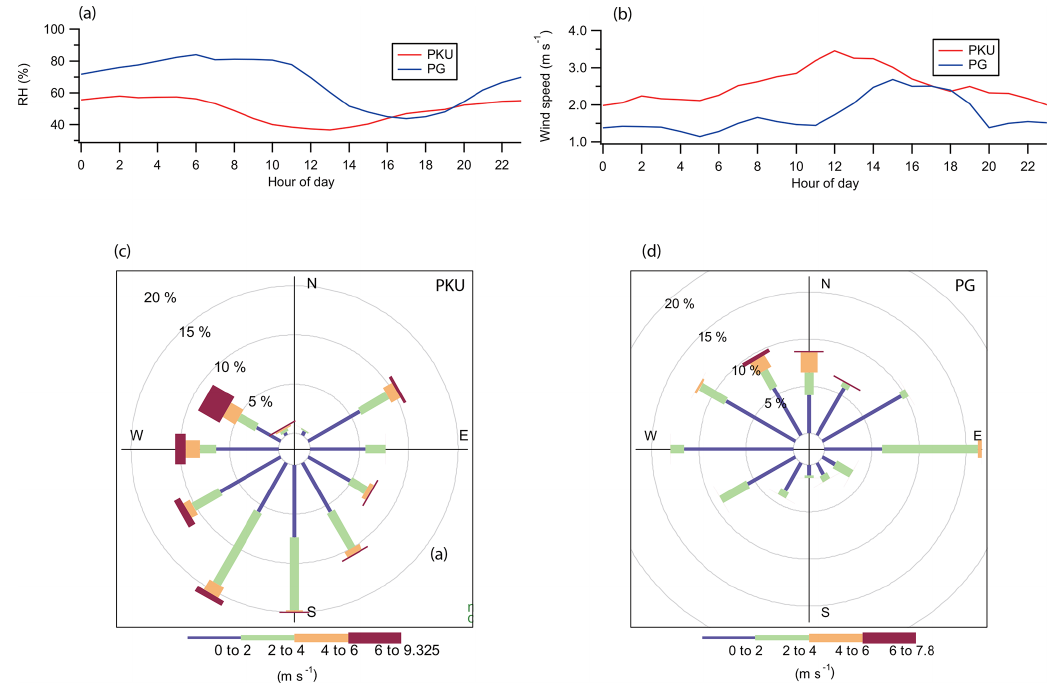
Figure 2. Diurnal plots of (a) RH and (b) wind speed; rose plots of wind at (c) PKU and (d)